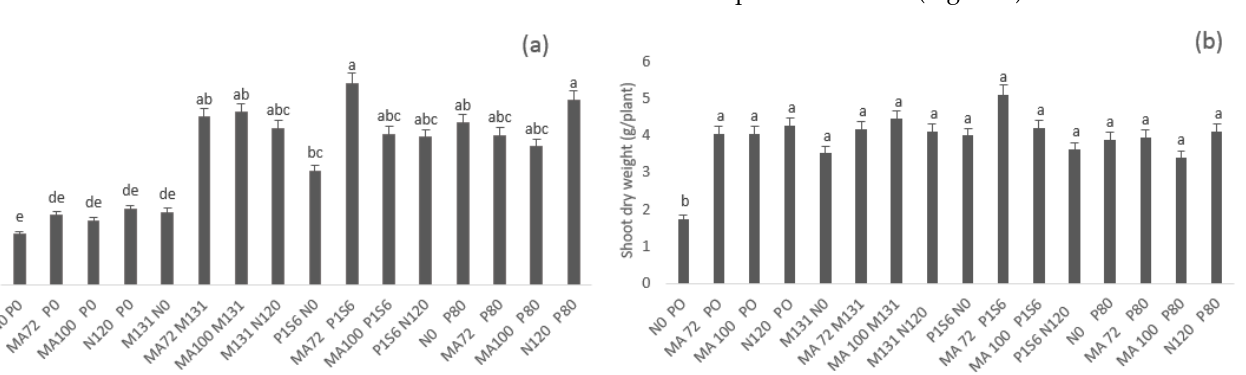
Figure 1. Effect of co-inoculation with Mesorhizobium spp. (MA72 or MA100) and Bacillus sp. (M131) or E. aerogenes (P1S6) and phosphate application combined to rhizobial inoculation on the number of nodules of chickpea in Merchouch ( a ) and Ain Sbit ( b ) sites. Bars followed by the same letter are not significantly different at α = 0.05. (P80 indicate application of 80 kg P2O5/ha, N120 indicate application of 120 kg N /ha, N0 and P0 indicate no nitrogen and phosphate fertilizers applica- tion).